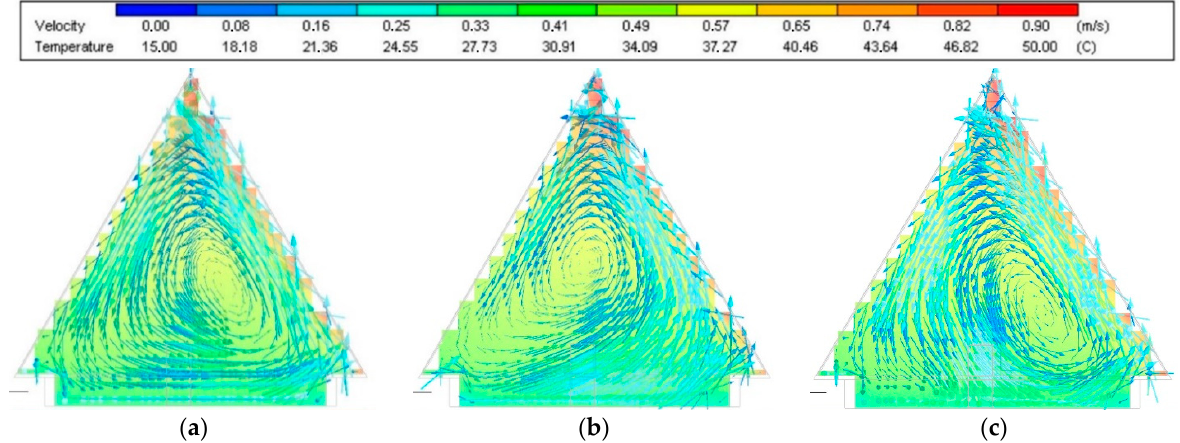
Figure 10. Simulated airflow paths on 6.6. at 12:00 a.m. in cross-section: ( a ) 0.8 m from the sanctuary wall; ( b ) in the middle of attic space; ( c ) 0.8 m from the wall of the tower.